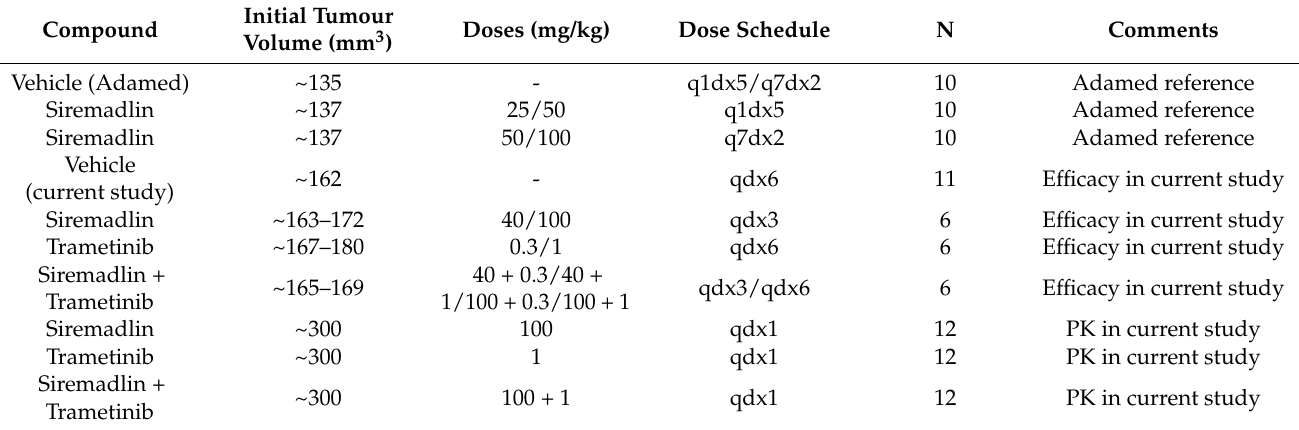
Table 1. Summary of performed in vivo studies on CD-1 nude mice xenografted with A375